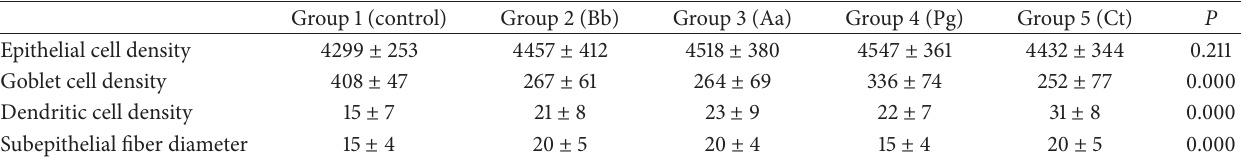
Table 3: In vivo confocal microscopy data between control (group 1) and antiglaucoma therapy groups (groups 2, 3, 4, and 5) (95% confidence